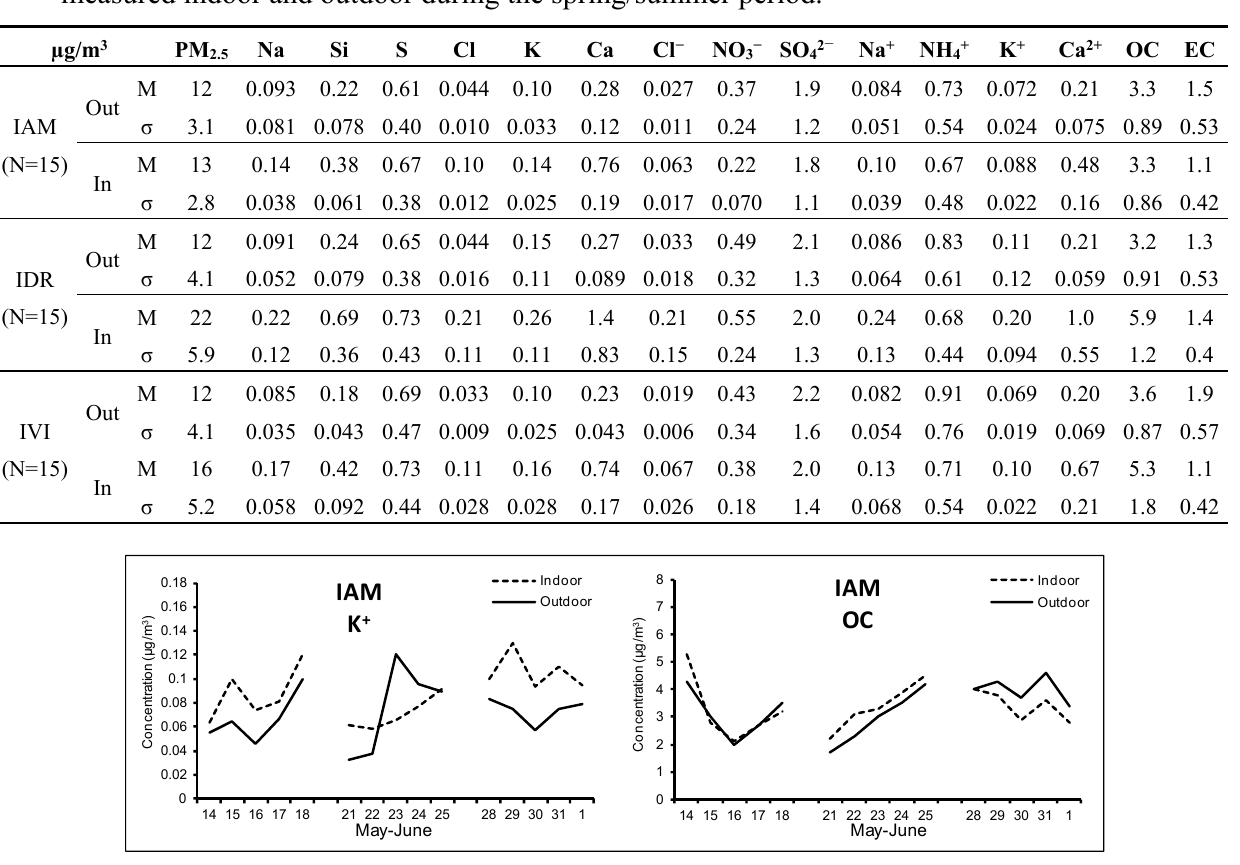
Figure 6. Outdoor and indoor time pattern for K + and OC at IAM site during the spring/summer